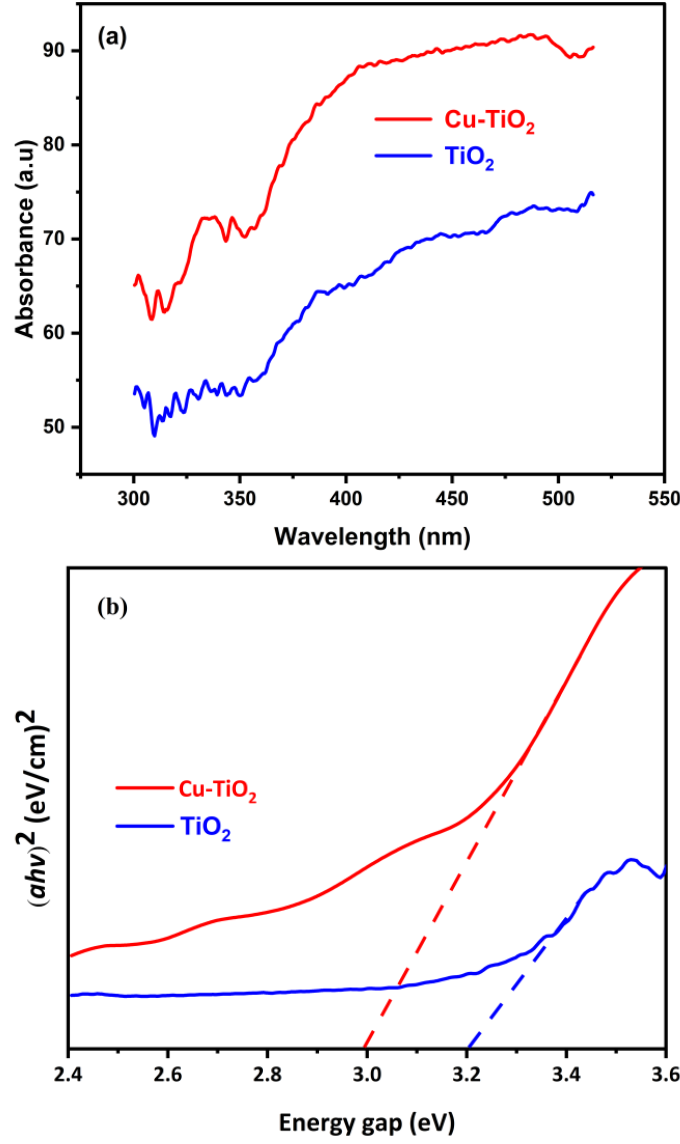
Figure 4. DRS ( a ) and Tauc’s plots analysis ( b ) of as-made plain TiO 2 and Cu-TiO 2 materials. The PL spectra of the pure TiO 2 and Cu-TiO 2 samples were investigated to comprehend the separation of e − /h + pairs and the charge–carrier transfer efficiency. Figure 5 shows a significant peak at around 388 nm in pure TiO 2 , which is assigned to the band-to-band recombination because it is near-band-edge luminescence. The peak in PL spectra of Cu-TiO 2 is observed at 376 nm, but with a drop in intensity. This intensity reduction refers to the inhibition of the recombination of the photo-generated electron from the conduction band (CB) to the valence band (VB) of TiO 2 . The higher PL peak intensity in pure TiO 2 refers to the reduction of the lifetime of the electron-hole pairs due to the fast recombination rate. Reda et al. [39] reported the highest reduction in PL intensity of doped-TiO 2 with Cu and N, revealing the examined samples’ efficacy in reducing photo- generated electron-hole recombination compared with pure TiO 2 . The intensity of the light absorption of TiO 2 was also decreased upon doping with Cu, implying that the rate of electron-hole recombination decreased in the doped product. It might result in the formation of higher reactive radical species and, thus, higher degradation performance in the developed photocatalytic process [40]. Therefore, it can be concluded that doping with copper significantly modified the properties of TiO 2 , which increased its photoactivity